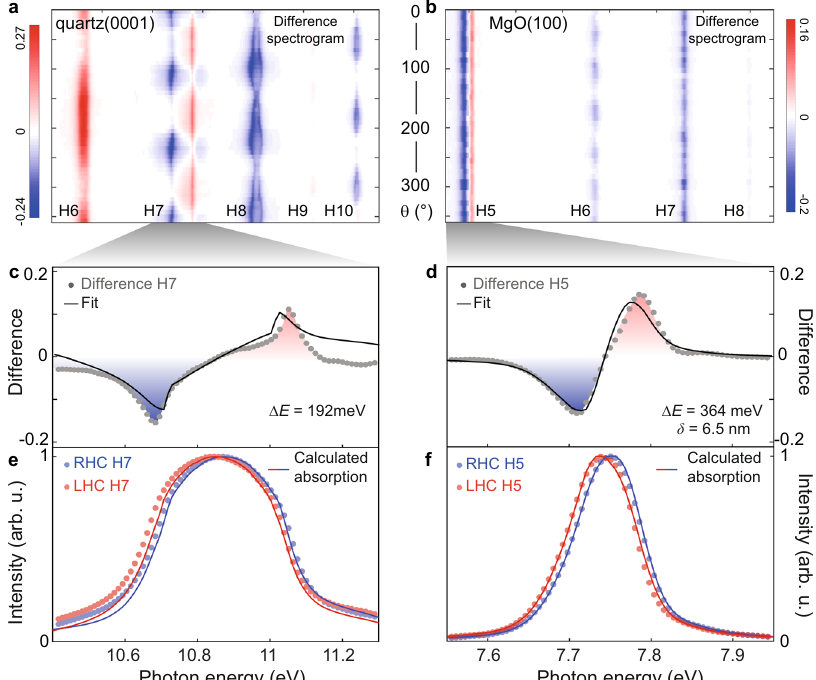
Fig. 3 Sensitivity of HHG to structural helicity of quartz and surface-ferromagnetic order of MgO. a , b Difference signal of two intensity-normalized spectrograms recorded with opposing helicities of the driving fi eld generated in ( a ) quartz(0001) and ( b ) MgO(100). For single helicity spectrograms cf. Fig. 1d and Supplementary Fig. S2. c , d Lineouts of the on-resonance harmonic difference signal in ( c ) quartz and ( d ) MgO. The solid lines represent a fi t based on calculations of the circular dichroism ( fi t parameters are the chiral energy splitting Δ E , and the effective interaction length δ ). e , f Normalized intensity of right-handed-circularly (blue, RHC) and left-handed-circularly (red, LHC) polarized harmonics in ( e ) quartz and ( f ) MgO. The solids lines represent the calculated circular dichroism. Lineouts are taken at an angle of θ = 120° in the case of quartz and averaged over all angles for MgO.